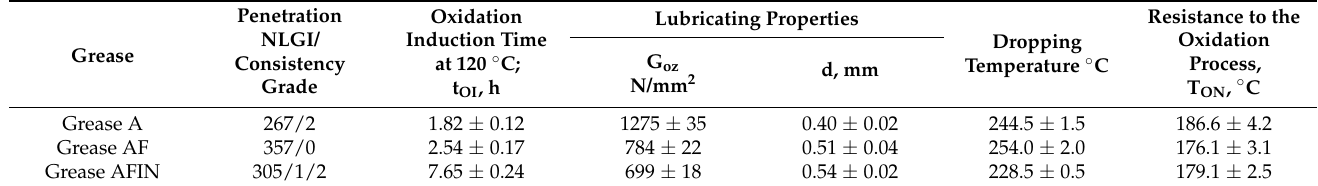
Table 5. The physical and chemical properties of the following greases: vegetable A, vegetable– mineral AF and mineral